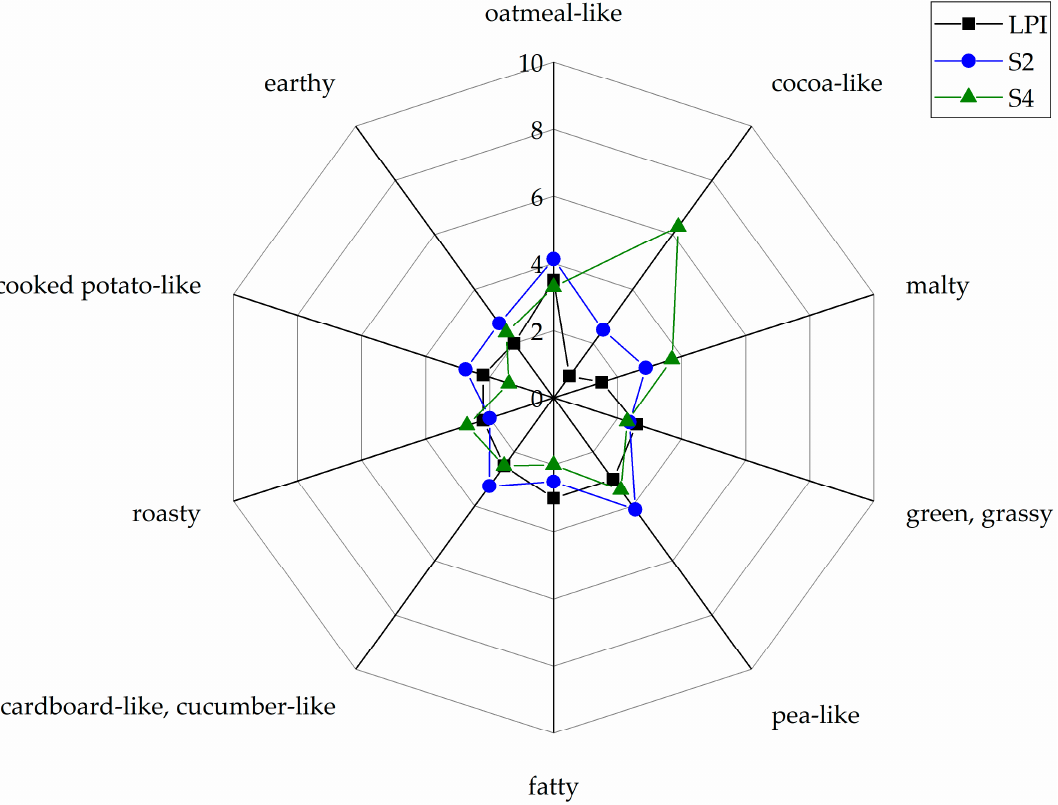
Figure 4. Comparative retronasal aroma profile analyses of LPI and fermented LPI hydrolysates (S2 and S4) on a scale from 0 (no perception) to 10 (strong perception). The data are displayed as mean values of the sensory evaluation (n = 10).